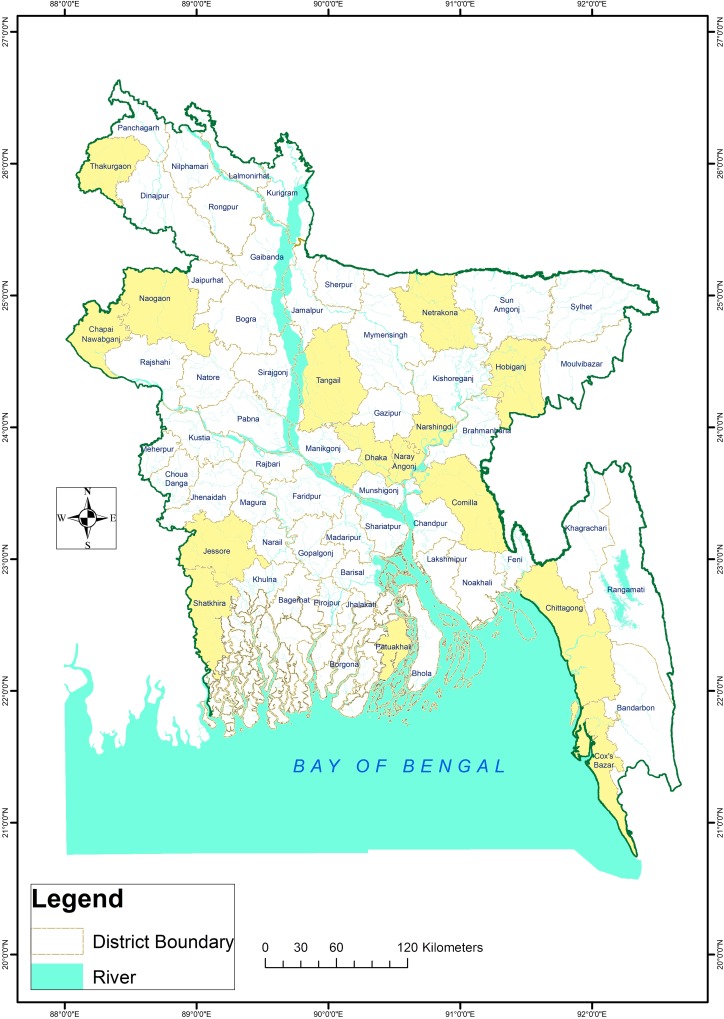
Surveillance sites.Map has been created by Arc GIS v 10.6.